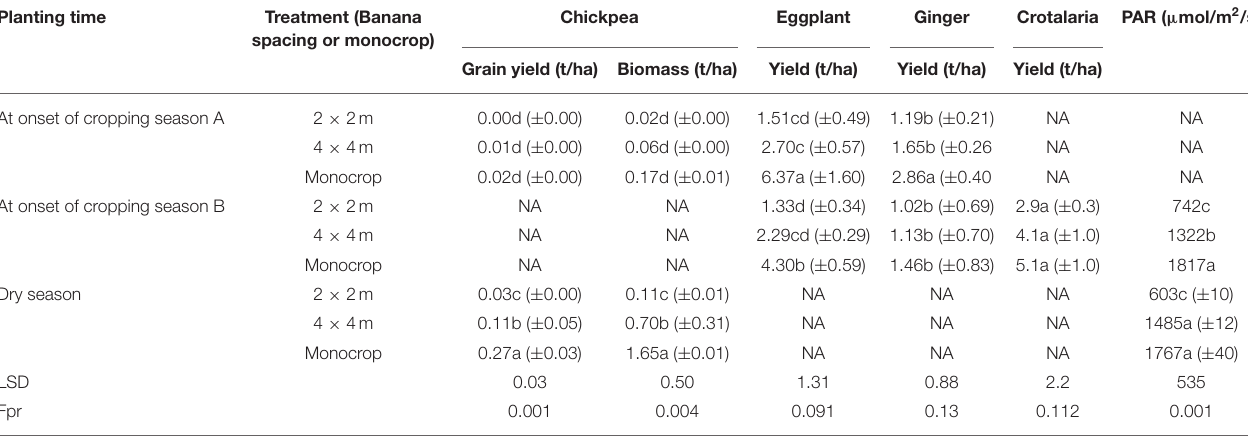
TABLE 3 | Yield and growth attributes of crops grown at INERA-Mulungu: chickpeas, eggplant, ginger, and the forage crop Crotalaria sp. Planting time